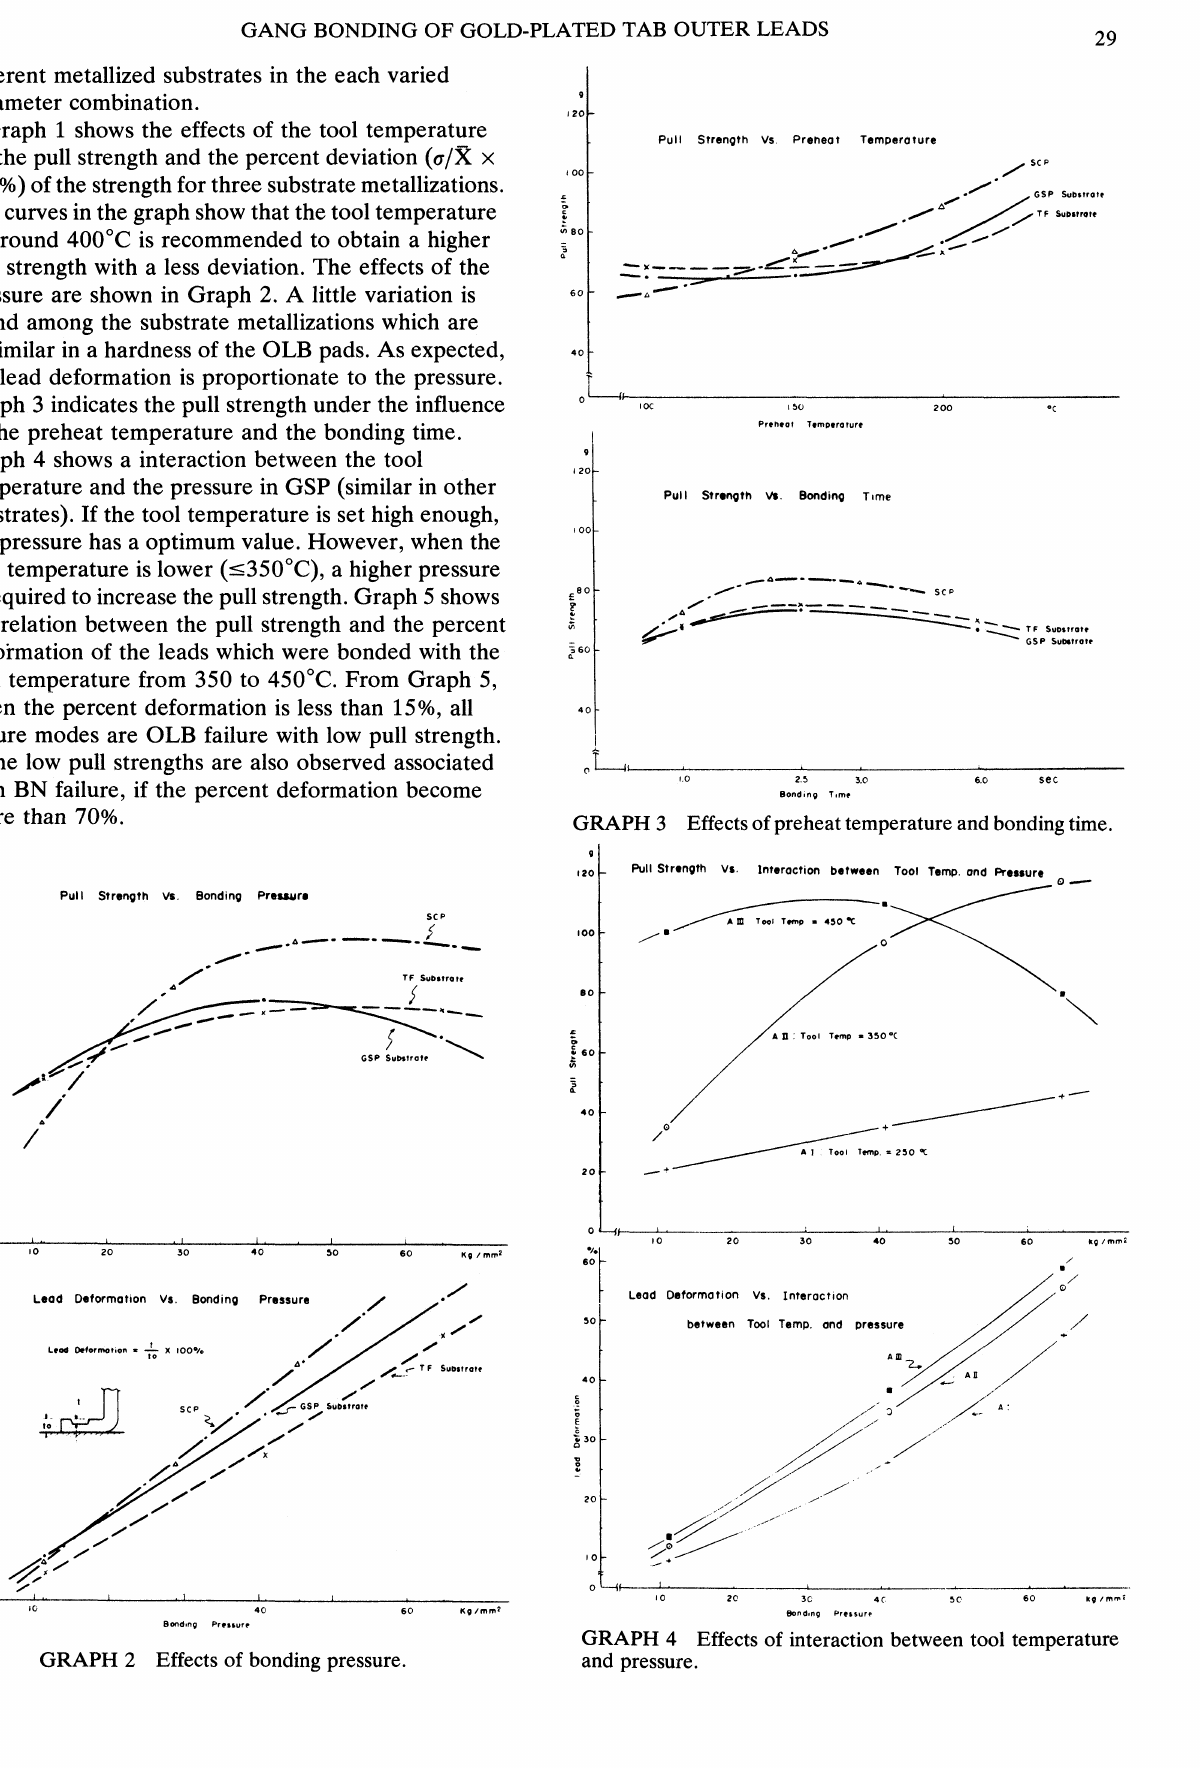
GRAPH 2 Effects of bonding pressure.